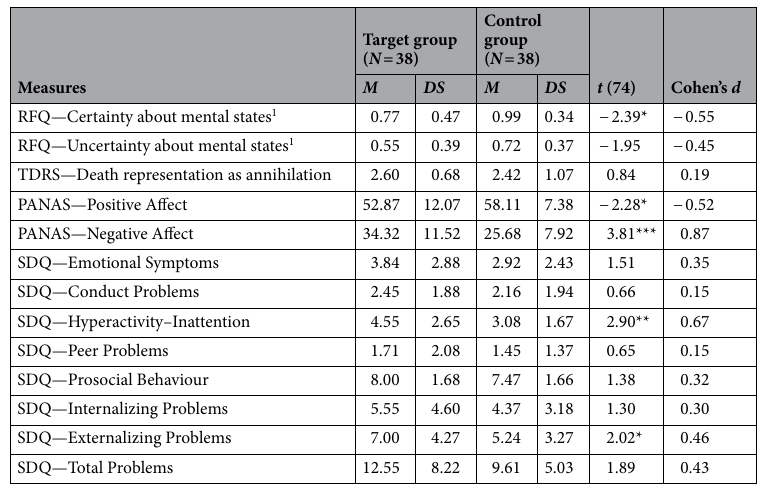
Table 1. Descriptive statistics of study variables for target group and control group with t-test results and Cohen’s d . 1 A square root transformation was applied to normalize the distribution of the two RFQ factors. * p < .05; ** p < .01; *** p <